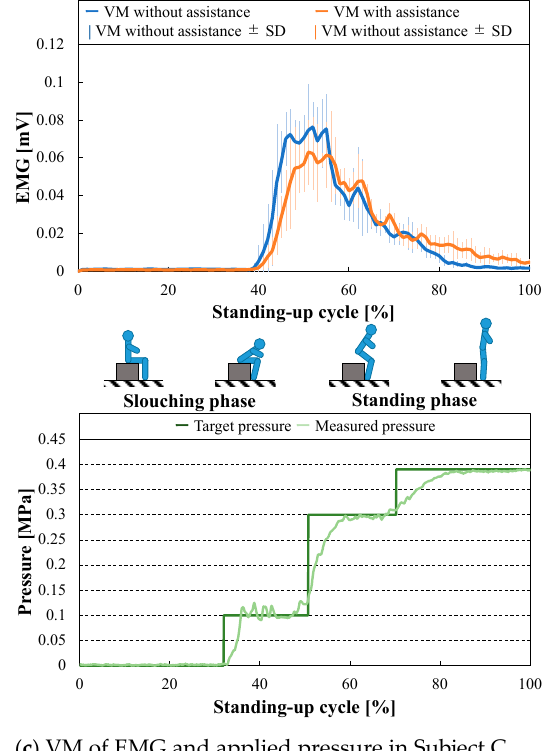
Figure 12. Comparison of EMG with and without assistance and applied pressure to the prototype in one standing-up cycle.